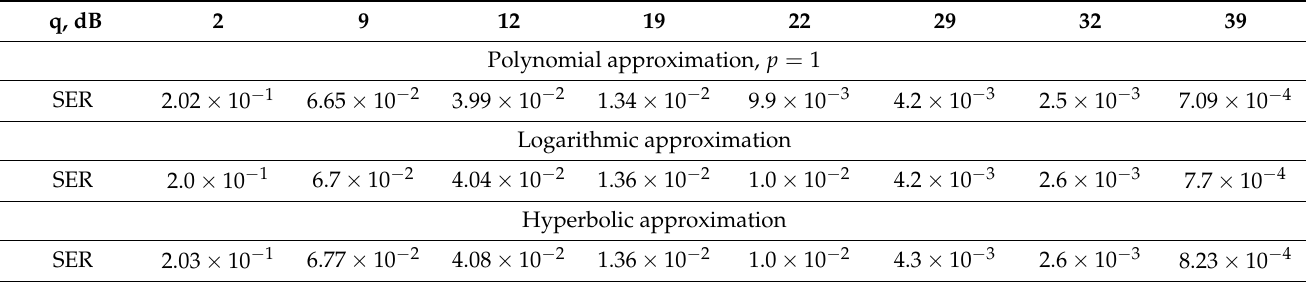
Table 6. SER of 4-QAM versus SNR per bit for m = 50, n 1 = 20, K 0 =